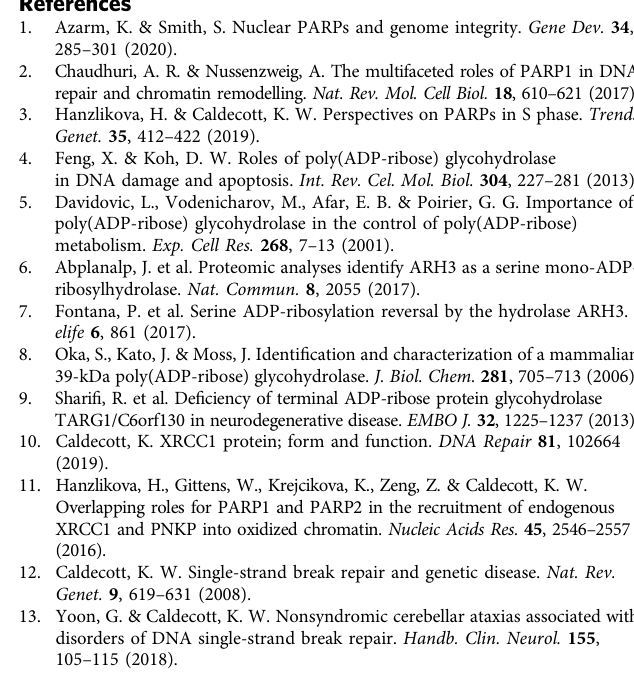
Fig. 6 Deregulated transcription in ARH3-defective cells. a NAD + depletion in wild-type, ARH3 − / − and XRCC1 − / − U2OS cells following DNA damage. Wild-type, ARH3 − / − and XRCC1 − / − U2OS cells were harvested 45 min after mock-treatment or treatment with either H 2 O 2 or MMS and NAD